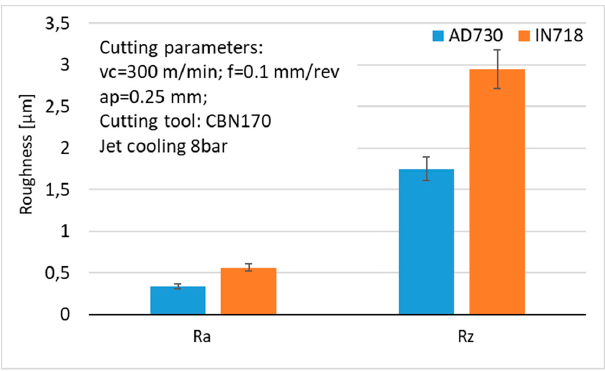
Figure 6. Surface roughness generated by AD730 ® and IN718. J. Manuf. Mater. Process. 2019 , 3 , x FOR PEER REVIEW